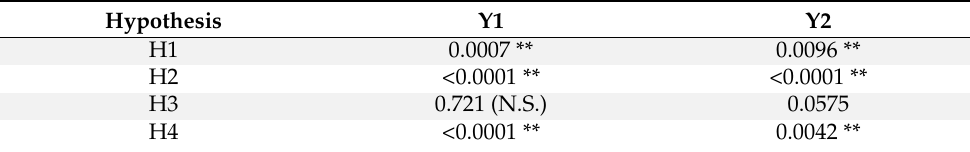
Table 4. Result of analysis 1.